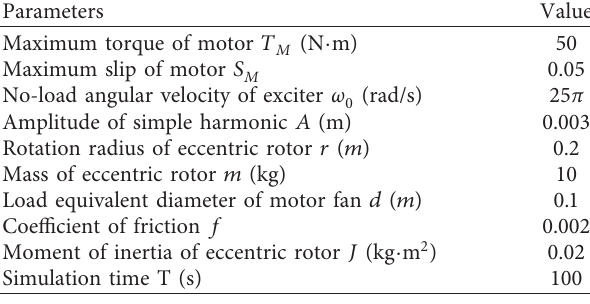
Table 1: Parameters of the vibration